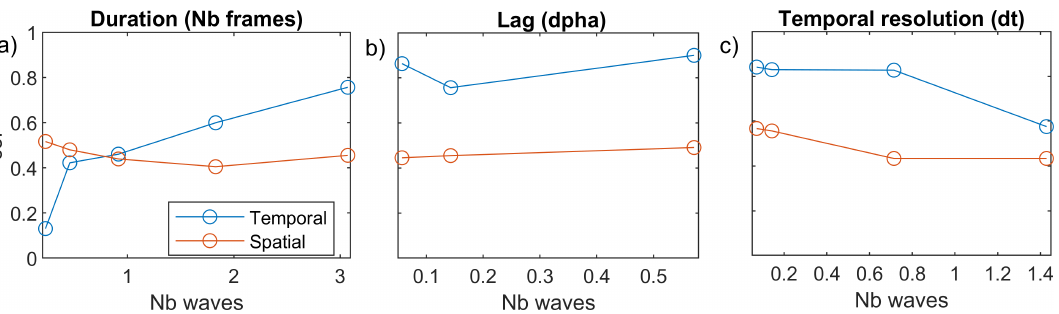
Figure 4. Sensitivity analysis of the temporal (blue) and spatial (red) versions of the correlation method to parameters: ( a ) to the number of frames in the video duration (here in terms of number of seen waves of a 7 s period, from 3 to 215 frames); ( b ) to the lag given to the waves to propagate (here in terms of a 7 s wave period, from 0.4 s, to 1 s, 4 s, and 10 s); and ( c ) to the temporal resolution dt (here in terms of a 7 s wave